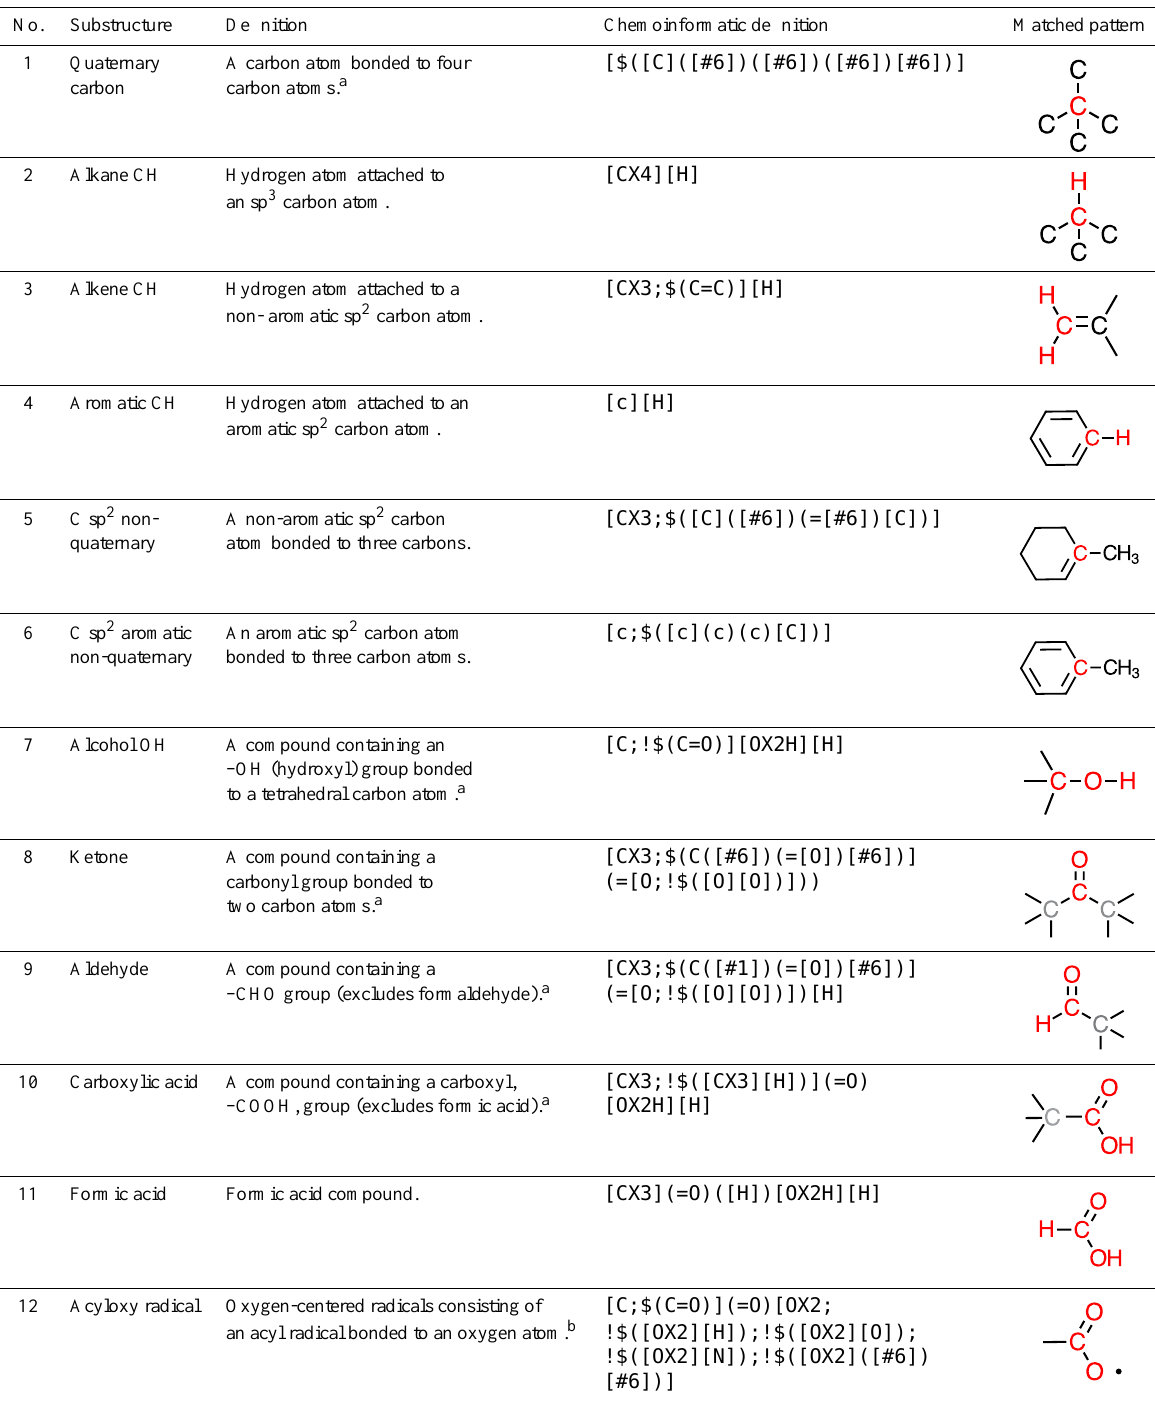
Table 1. Substructures matched in order to account for the complete set of carbons and oxygen atoms in the set of compounds constituting the α -pinene and 1,3,5-trimethylbenzene degradation scheme in MCM v3.2 (substructures 1–33) and extra molecular substructures measurable with FTIR (substructures 33–57). For space constraints the SMARTS patterns have been reported on multiple lines, even if the SMARTS notation requires unique